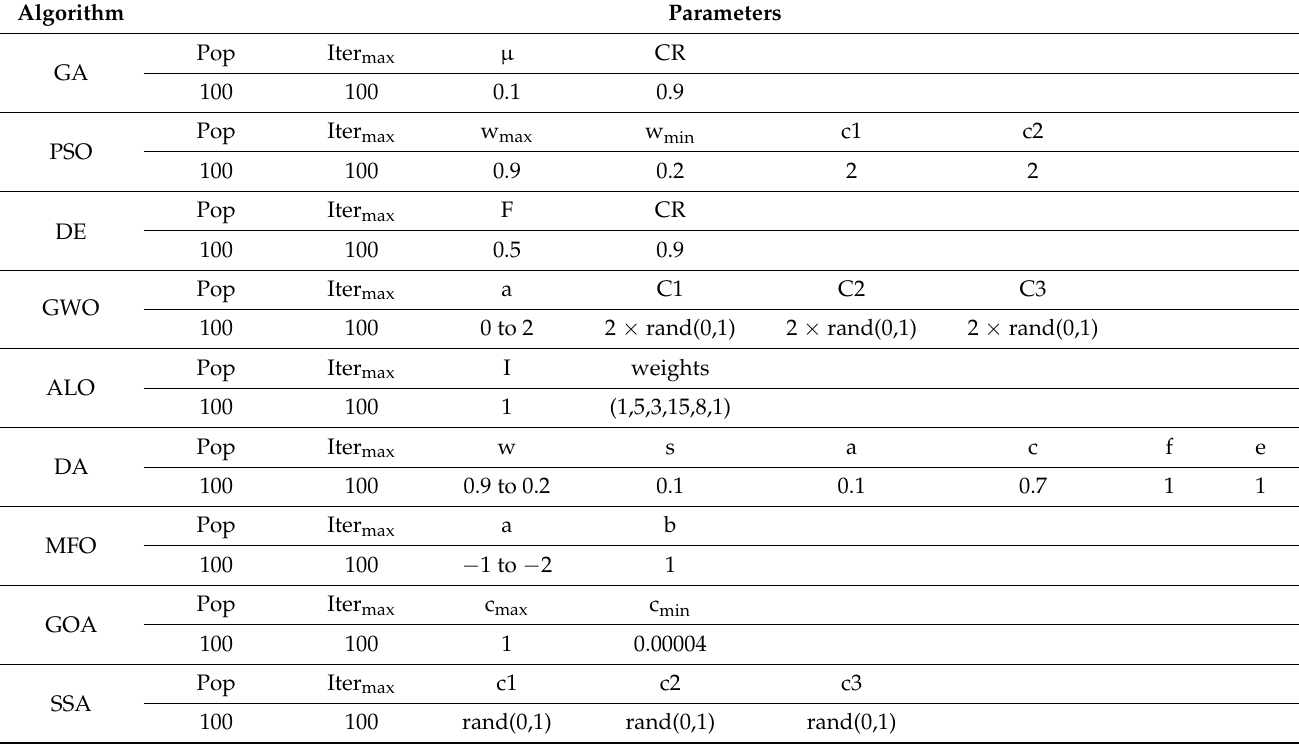
Table 4. Control parameters of the